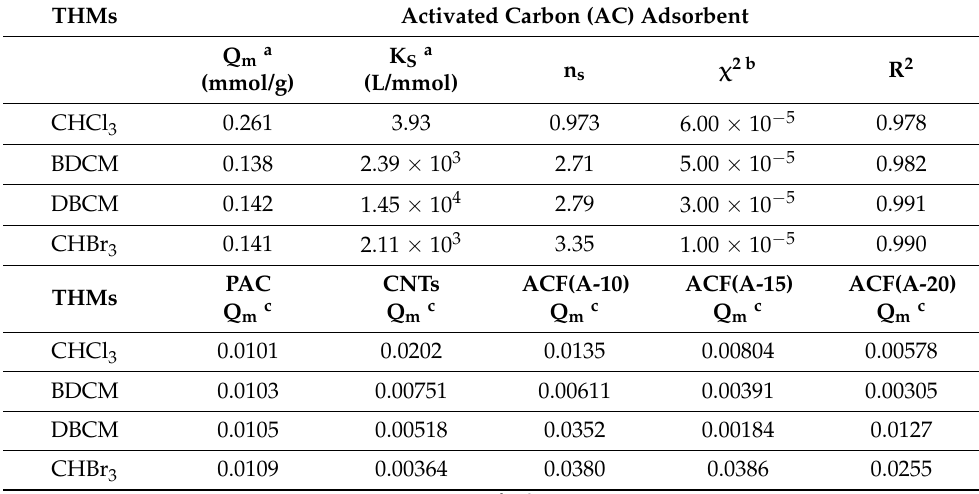
Table 6. Sips isotherm model parameters (Q m , K s , and n s ) for activated carbon and other carbona- ceous materials from the literature with THMs at pH 6.5 and 295